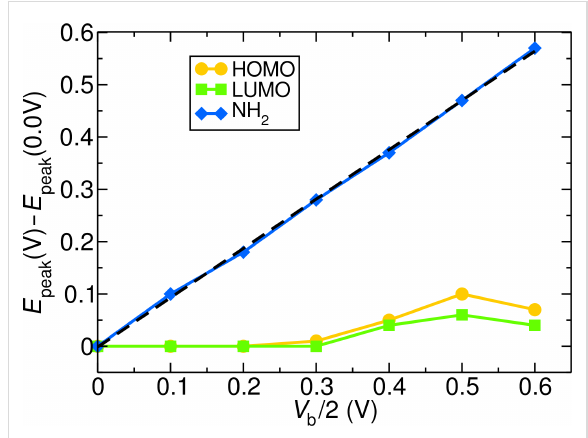
Figure 3: Shift of HOMO, LUMO and NH 2 states with respect their equilibrium position as a function of the applied bias V b in the CA junc- tion. The black dashed line represents a linear regression fit with slope of 0.942. Adsorbate states follow the electrostatic potential of the left electrode. NHC states are not pinned to either electrode and exhibit a non-monotonic behavior with applied voltage, as discussed in the text.